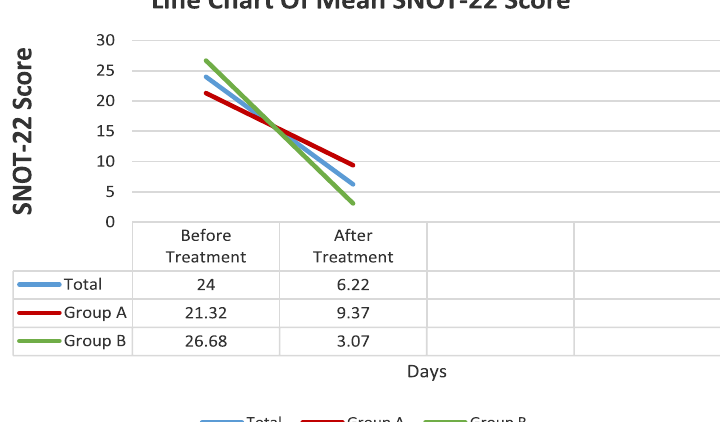
Fig. 3 Mean total SNOT-22 score of groups A and group B before and after treatment. Blue color represents all patients receiving the treatment. Red color represents all patients in group A. Green color represents all patients in group B. The overall SNOT-22 mean score in all patients before the treatment was 24 11.87 and after the treatment was 6.22 6.1. The overall SNOT-22 mean score in patients before the treatment in groups ± ± A and group B was 21.32 11.29 and 26.68 11.92, respectively. The overall SNOT-22 mean score in patients after the treatment in group A was ± ± 9.37 6.55 and in group B was 3.07 3.46. The line graph shows greater improvement in the mean SNOT-22 after treatment in patients in group B ± ± receiving amoxicillin and mometasone furoate nasal